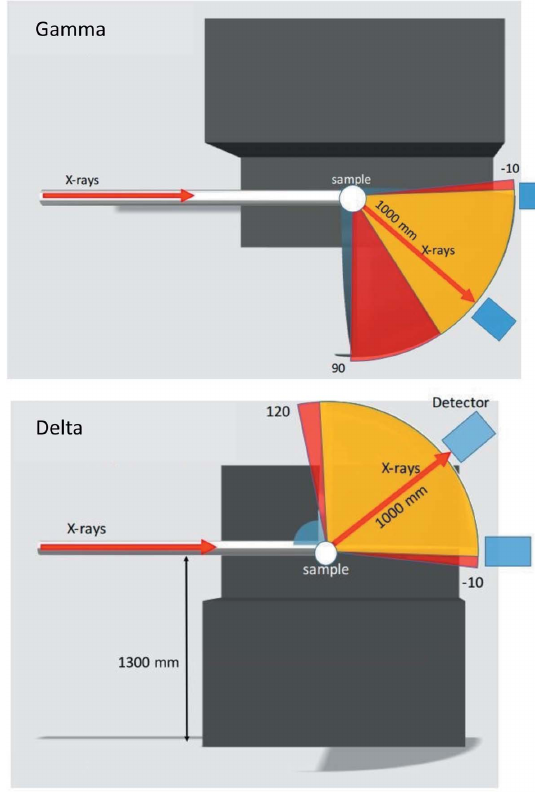
Figure 12 Schematics of the angular range available for the robot arm in the horizontal (gamma, from a top view) and vertical (delta, from a side view) directions. The yellow and red areas represent the minimum and the optimal requirements for the accessible angular range, respectively. The minimum sample–detector distance is 250 mm, while the maximum is 1000 mm in the whole range and can go up to 1200 mm in a small angular range close to the forward beam